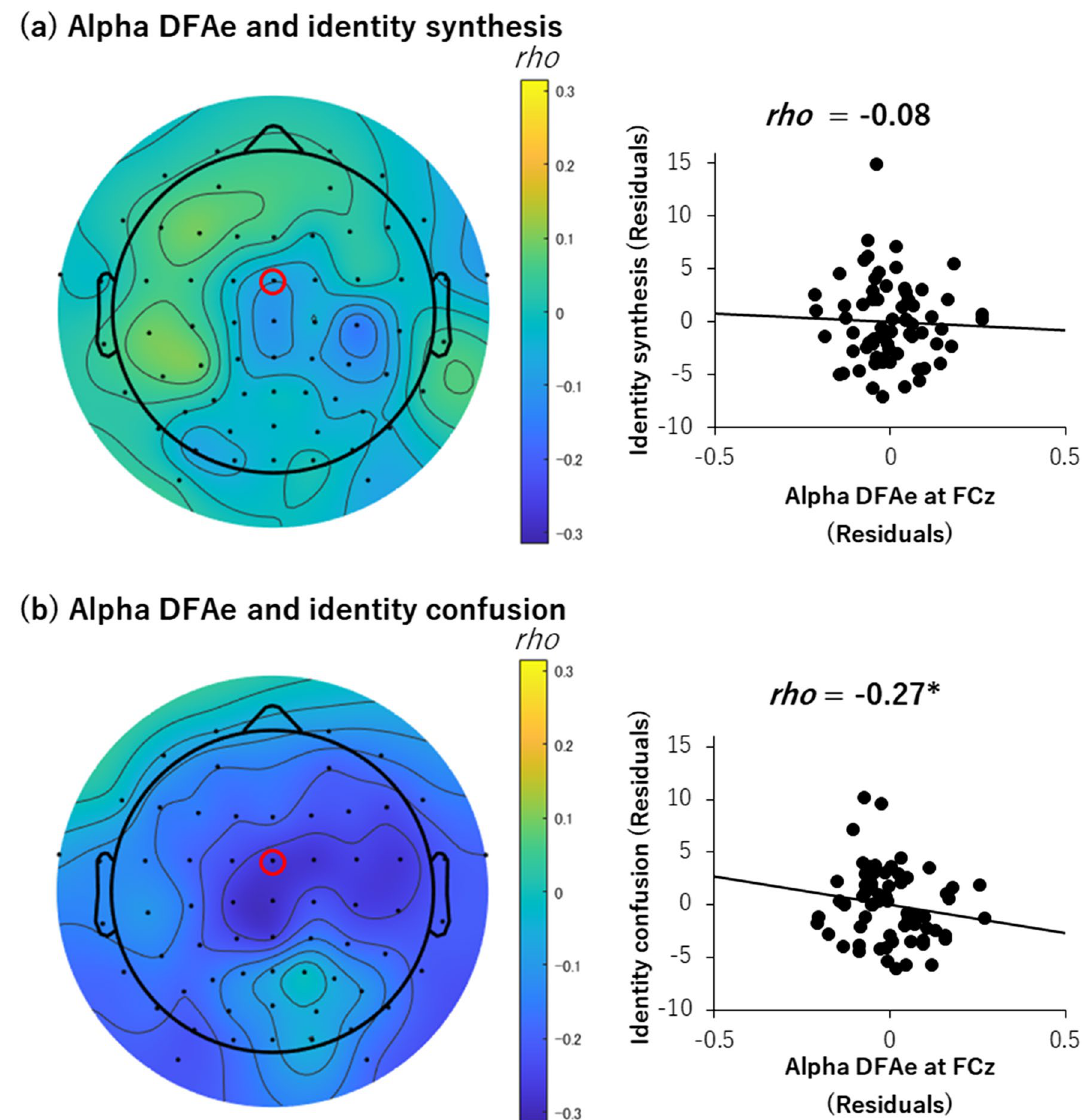
Figure 2. Topo maps and scatterplots of Spearman’s partial correlation analyses. ( a ) Correlation between alpha range DFAe at FCz and identity synthesis. ( b ) Correlation between alpha range DFAe at FCz and identity confusion. *Adjusted p < 0.05 (one-tailed). The red circle on each topo map indicates an electrode; the data from which is shown in the scatterplot. Topo maps were created by EEGLAB toolbox (ver.14.1.2b, https ://sccn.ucsd. edu/eegla b/index .php) 55